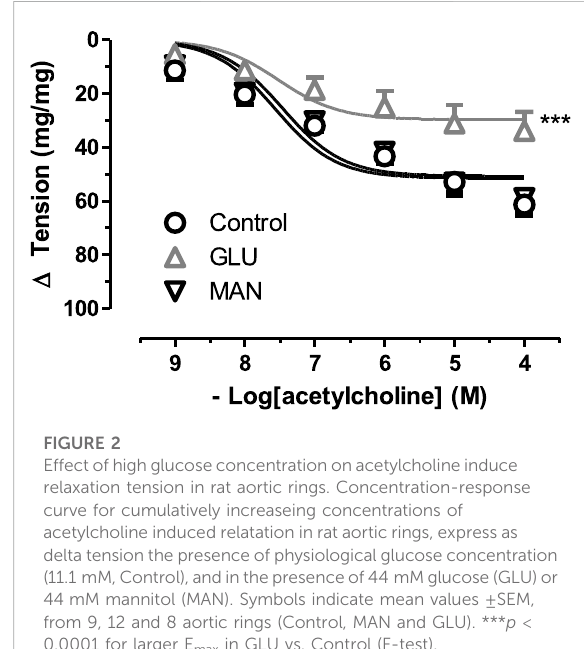
FIGURE 2 Effect ofhighglucoseconcentration onacetylcholineinduce relaxation tension in rat aortic rings. Concentration-response curve for cumulatively increaseing concentrations of acetylcholine induced relatation in rat aortic rings, express as delta tension the presence of physiological glucose concentration (11.1 mM,Control),andinthepresenceof44 mMglucose(GLU)or 44 mM mannitol (MAN). Symbols indicate mean values ±SEM, from 9, 12 and 8 aortic rings (Control, MAN and GLU). *** p < 0.0001 for larger E max in GLU vs. Control